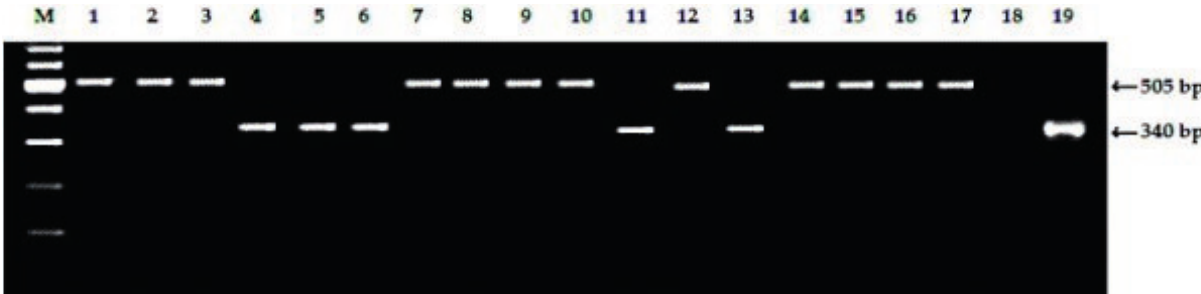
Figure 2. DNA amplification products for wheat cultivars and elite lines obtained with diagnostic marker XEE444541 linked to the Tsc2 gene sensitive to Ptr ToxB. Lane: M, molecular weight marker (Gen-RulerTM; 100 bp DNA Ladder), 1, GF_1_CP; 2, GF_10_CP; 3, 609_SP2;